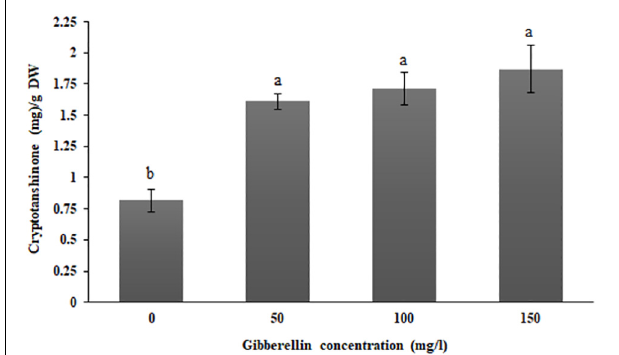
FIGURE 2 | GA 3 treatment-induced increase the cryptotanshinone biosynthesis in S. abrotanoides plants. Treatments with sterile water without GA 3 supplementation (0 mg l − 1 ) were considered as controls. Each value represents the mean ± standard error of three replicates; letters (a and b) indicate significant differences at P < 0.05. The experiments were conducted with three biological replicates for each tested concentration.